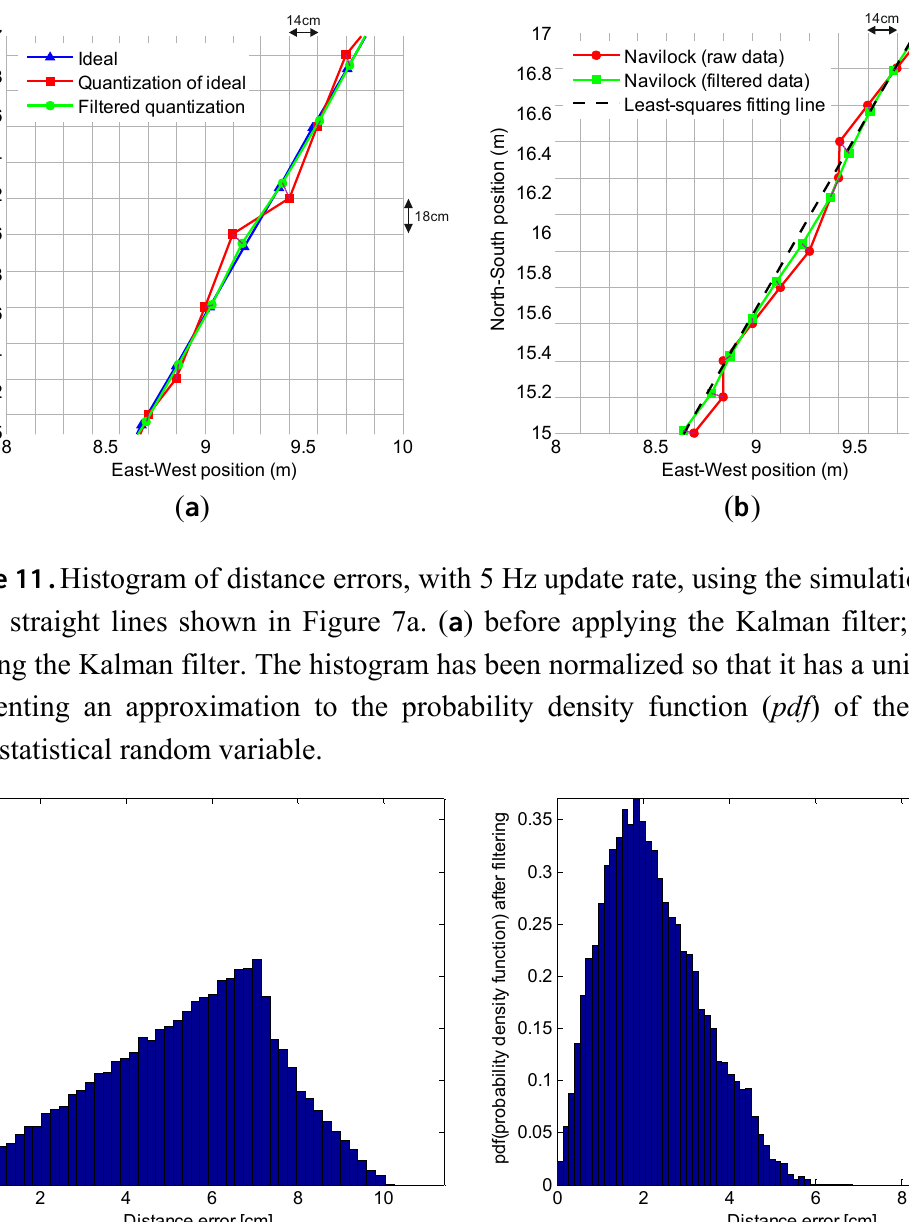
Figure 10. Results of positioning improvement at a 5 Hz update rate, constant speed of 5 km/h (3.1 mph) and 60° heading angle along a straight path ( a ) in a simulation with artificial data; and ( b ) in tests, processing data from a real onboard Navilock NL-402U GPS receiver. The purple line joins two corresponding points, before and after the filtering, to qualitatively show the negligible magnitude of the delay.